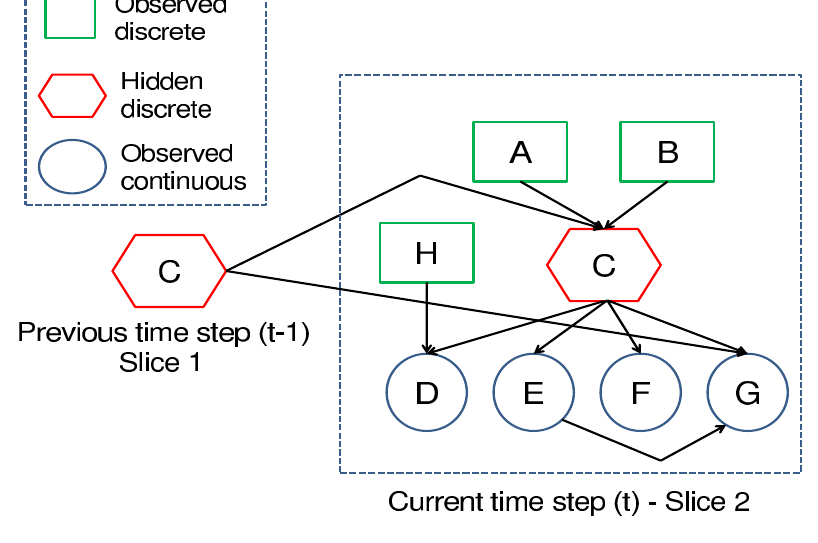
Figure 3. The 1.5 DBN model used to assess the data quality of individual temperature and conductivity sensors in Sullivans Cove, Hobart at 1 m and 10 m. The causes of sensor degradation in this model were the time since the sensor was calibrated in node A and the time since the sensor was cleaned in node B . The latent states used to infer the data quality in node C were defined by the IOC flagging standard. The observed evidence of data quality was the seasonal difference in node D , the gradient in node E , the difference between the sensor and hydrodynamic model in node F (only for sensors at 1 m) and in node G the difference between equivalent sensors at alternate depths.